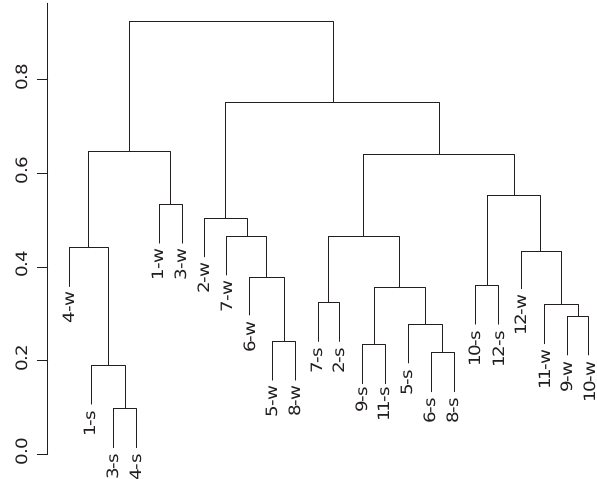
Figure 6. Dendrogram of grouping (UPGMA, Bray-Curtis) in streams with different land uses influence in Erechim. Numbers = sites, w = winter, s = summer. Urban Sites: numbers 1, 2, 3, and 4; Agri- culture Sites: numbers 5, 6, 7, and 8; Reference Sites: numbers 9, 10, 11, and 12.